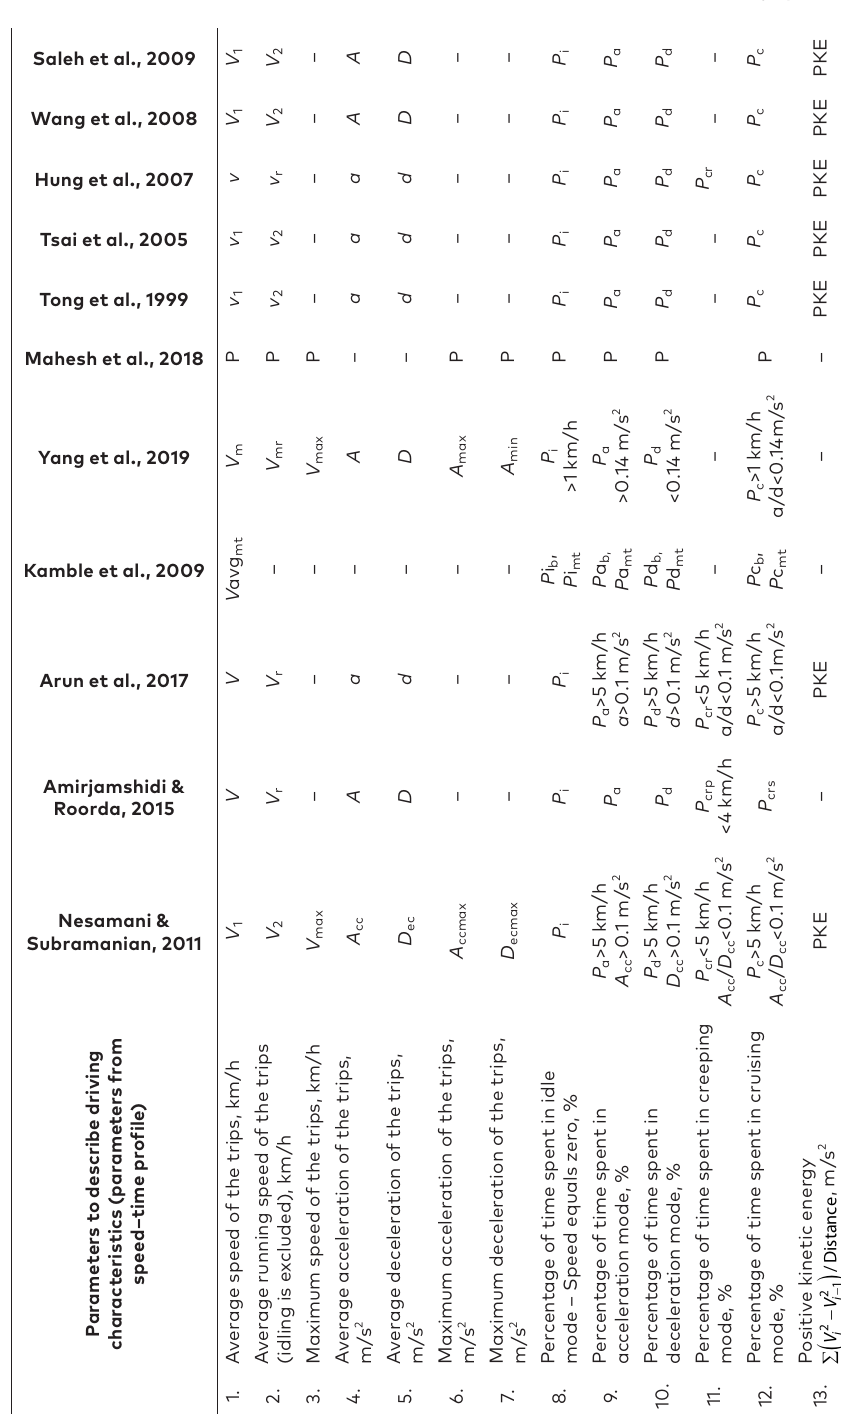
Table 1. Assessment measures to develop the driving